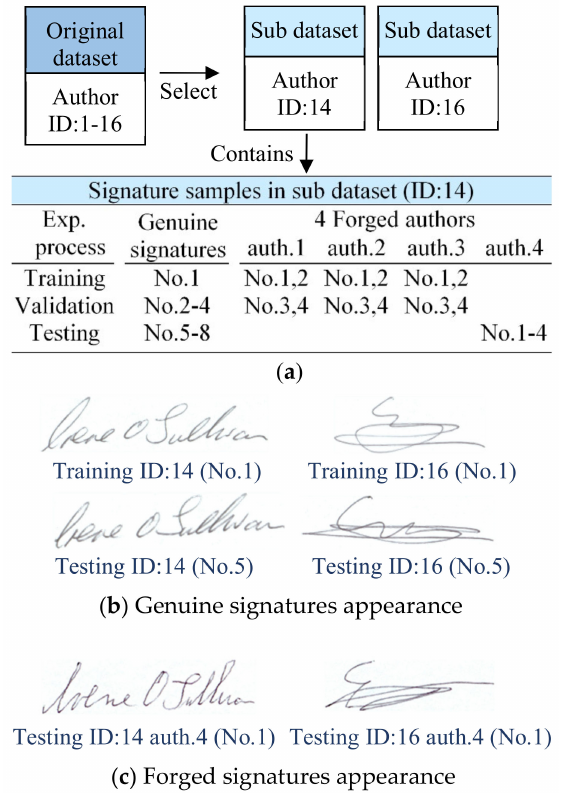
Figure 4. ( a ) Sub-datasets used for experiment; ( b ) genuine signatures appearance in training stage; ( c ) forged signatures appearance in testing